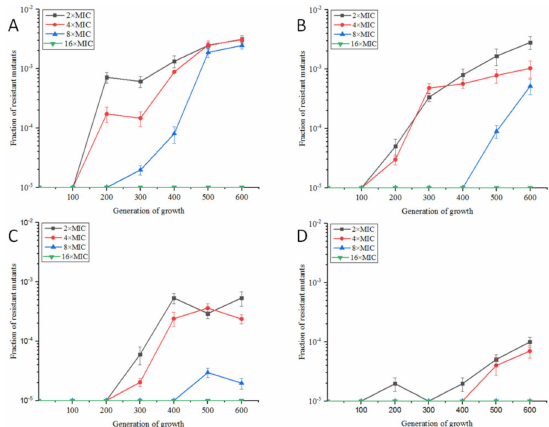
Figure 1. Resistance rates of E. coli ATCC25922 exposed to OLA at sub-MIC concentrations of 1 / 2 × MIC ( A ), 1 / 4 × MIC ( B ), 1 / 10 × MIC ( C ) and 1 / 100 × MIC ( D ). Di ff erently, 1 / 2 × MIC and 1 / 4 × MIC Enrofloxacin (ENR)-induced E. coli appeared colonies on 2 × MIC and 4 × MIC ENR plates from 100 generations, and the resistance rates for 2 × MIC